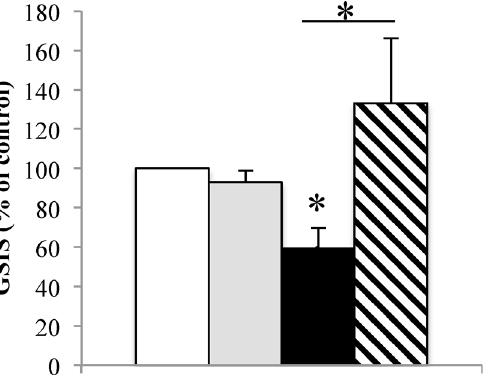
Fig 4. Anisomycin restores GSIS in palmitate condition in human islets. GSIS were measured after 48h BSA (white bar) + anisomycin (200 nM; grey bars) or palmitate (black bar) treatment + anisomycin (200 nM; hatched bars) in 6 human islet different preparations. * p <